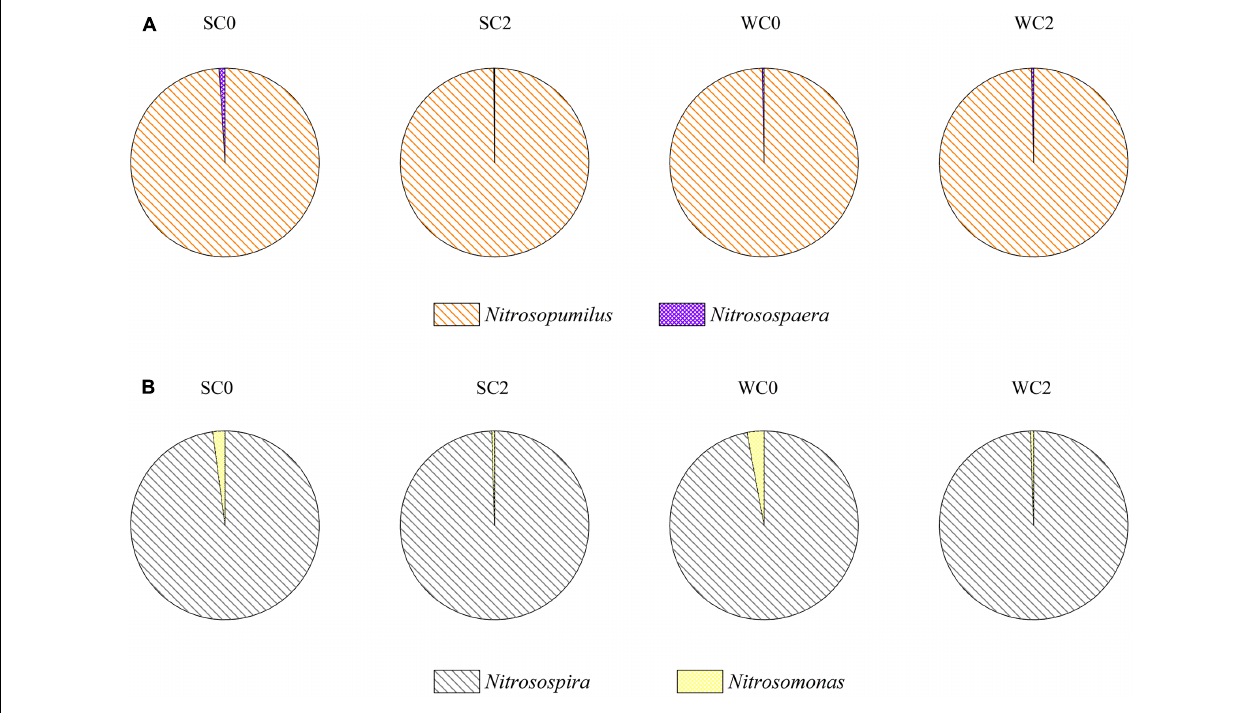
FIGURE 4 | Distribution and relative abundance of phylogenetic AOA (A) and AOB (B) groups.